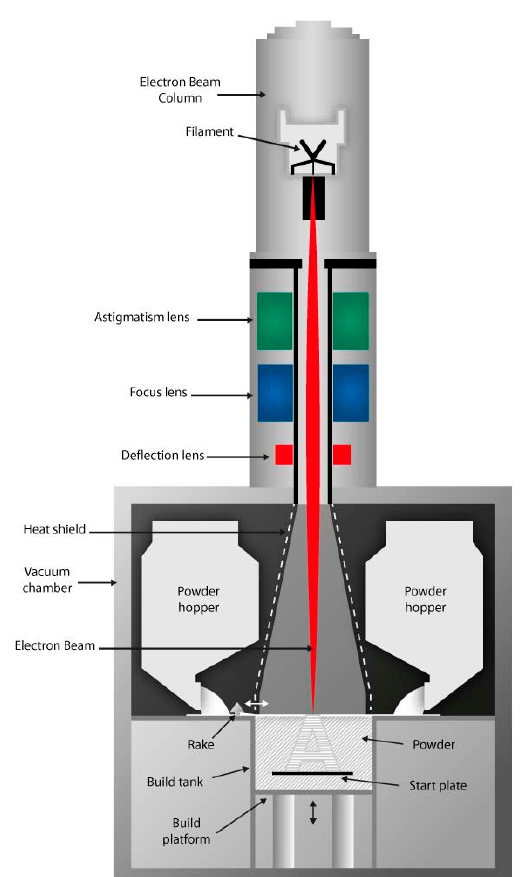
Figure 1. Schematic of the electron beam melting (EBM) process [4].